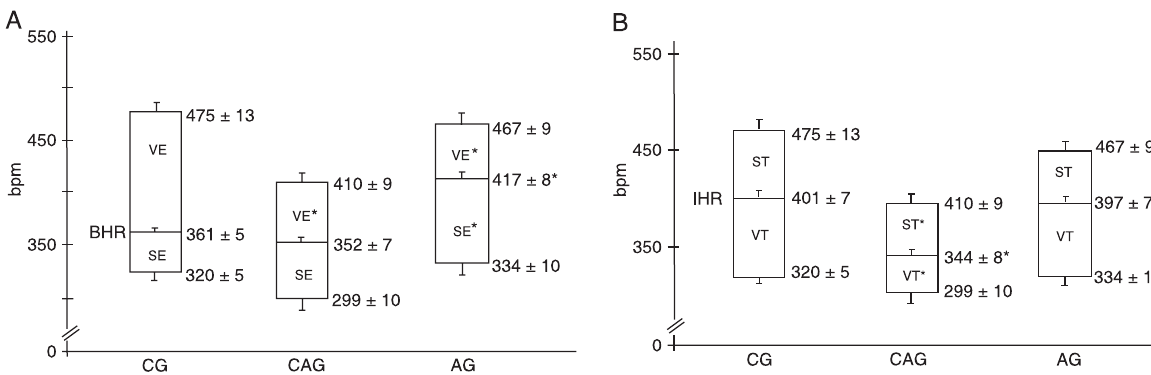
Figure 1. A , Vagal (VE) and sympathetic (SE) effect and B , vagal (VT) and sympathetic (ST) tonus of the control group (CG), carotid group (CAG) and aortic group (AG). IHR = intrinsic heart rate; BHR = basal heart rate. *P < 0.05 versus CG (one-way